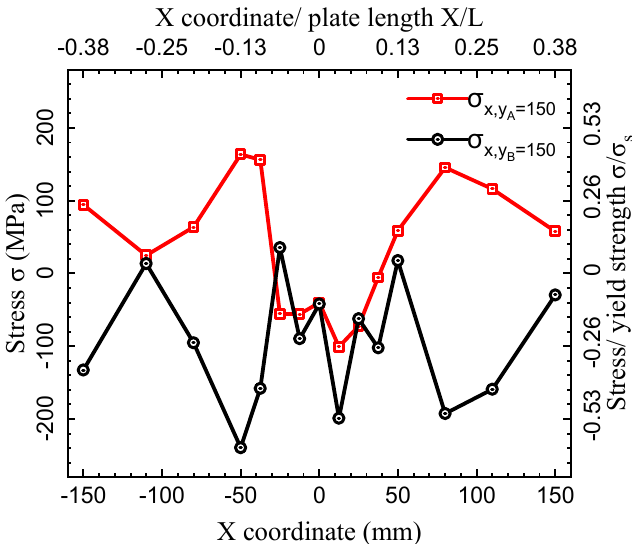
Figure 16. 𝜎 (cid:3051) on surfaces A and B. Figure 16. σ x on surfaces A and